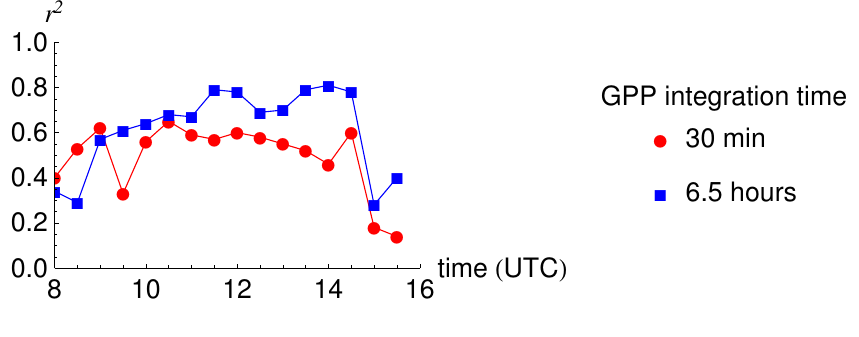
Figure 8. Coefficient of determination from the linear regression between SIF760 and GPP as a function of measurement time in clear sky conditions. Red points: GPP is averaged over a 30 min interval at the same time as SIF760. Blue squares: GPP is averaged over the day from 8:00 to 15:30